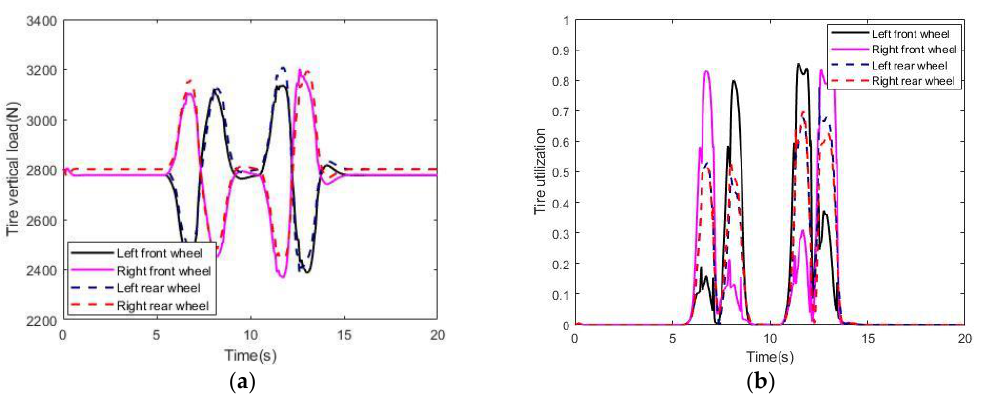
Figure 9. Tire state: ( a ) tire vertical load; ( b ) tire utilization.